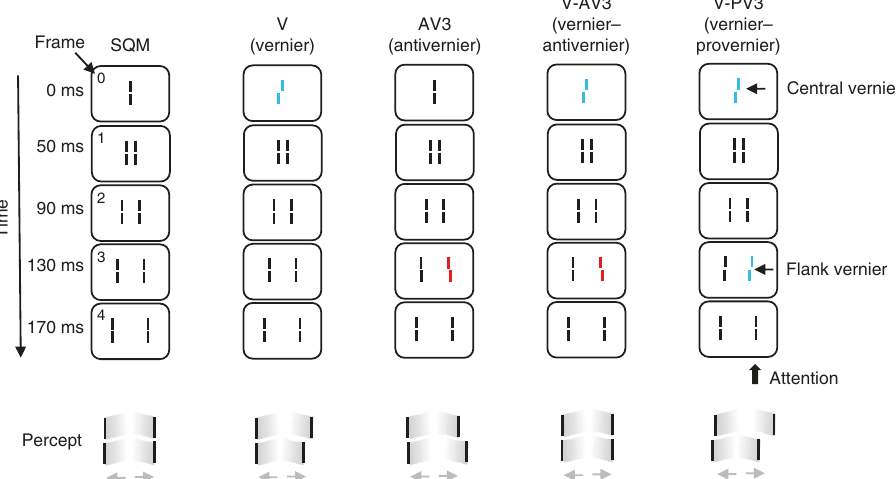
Fig. 1 The Sequential Metacontrast paradigm (SQM). A central line is followed by pairs of fl anking lines. Each line is presented for 20 ms, the inter-stimulus interval (ISI) is 20 ms (except the fi rst ISI, which is 30 ms). A percept of two diverging streams is elicited. Observers attend to one of the streams (here, the right stream) and report the perceived offset direction (right/left) by pressing hand-held push-buttons. Condition V (vernier): only the central line is offset. The offset is visible at the following lines and observers report the offset direction. Condition AV (anti-vernier): only a fl anking line is offset. The offset is visible in the attended stream. Condition V-AV (vernier-anti-vernier): the central line and one of the fl anking lines are offset. The two offsets are in opposite directions and cancel each other. Observers cannot report the individual vernier offsets. Condition V-PV (vernier – pro-vernier): the central line and one of the fl anking lines are offset. The two offsets are in the same direction and add up. Notation: For example, V-AV3 indicates that the central line and the fl anking line in frame 3 are offset in opposite directions. The red and blue offset colors are for illustration purposes only. All elements were the